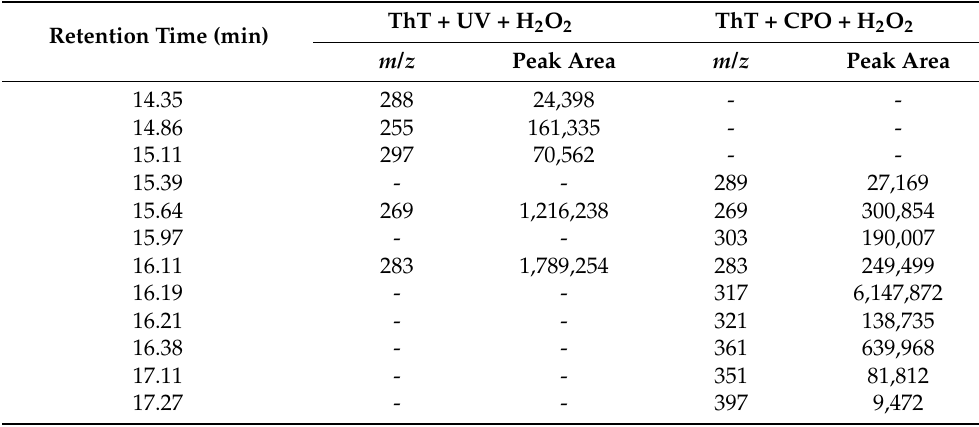
Table 1. Peak area of intermediates produced during the degradation of ThT by UV + H 2 O 2 and CPO + H 2 O 2